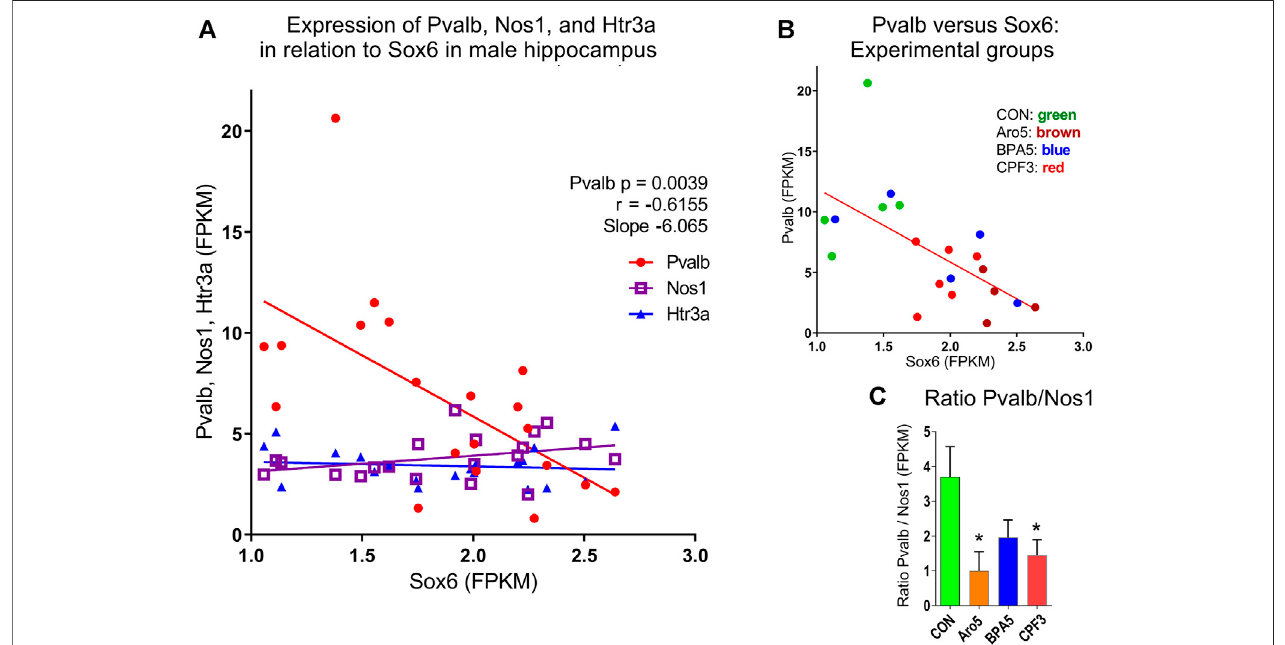
FIGURE6| RelationshipbetweenSox6andinterneuronmarkersexpressedinindividualhippocampussamplesofmaleoffspringatpostnatalday6(RNAseqdata, FPKM values). (A) Inverse correlation between expression of Parvalbumin (Pvalb) expressed in medial ganglionic eminence (MGE)-derived interneurons and Sox6, p (cid:1) 0.0039, r (cid:1) − 0.6155, slope (cid:1) − 6.065. No correlation between Sox6 and levels of neuronal nitric oxide synthase (Nos1) expressed in subgroup of MGE-derived interneurons, or serotonergic ionotropic receptor Htr3a expressed in caudal ganglionic eminence-derived interneurons, both independent of Sox6. (B) Correlation between Pvalb and Sox6 with identi fi cation of treatment groups. C. Expression ratio of Pvalb/Nos1, mean ± S.E.M, N (cid:1) 5-6.